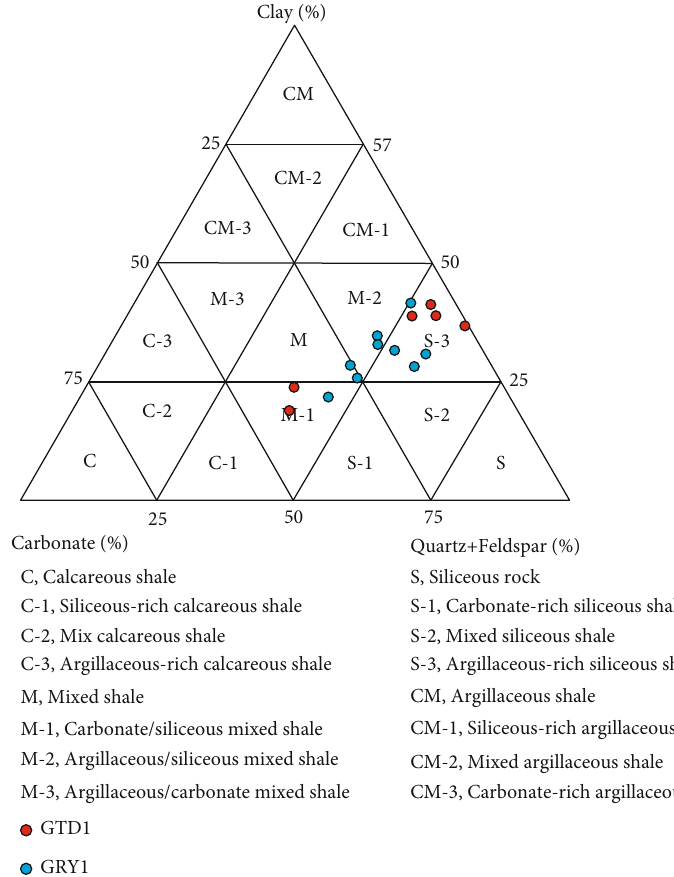
Figure 3: Ternary diagram of mineral compositions of shale samples in well GRY1 and well